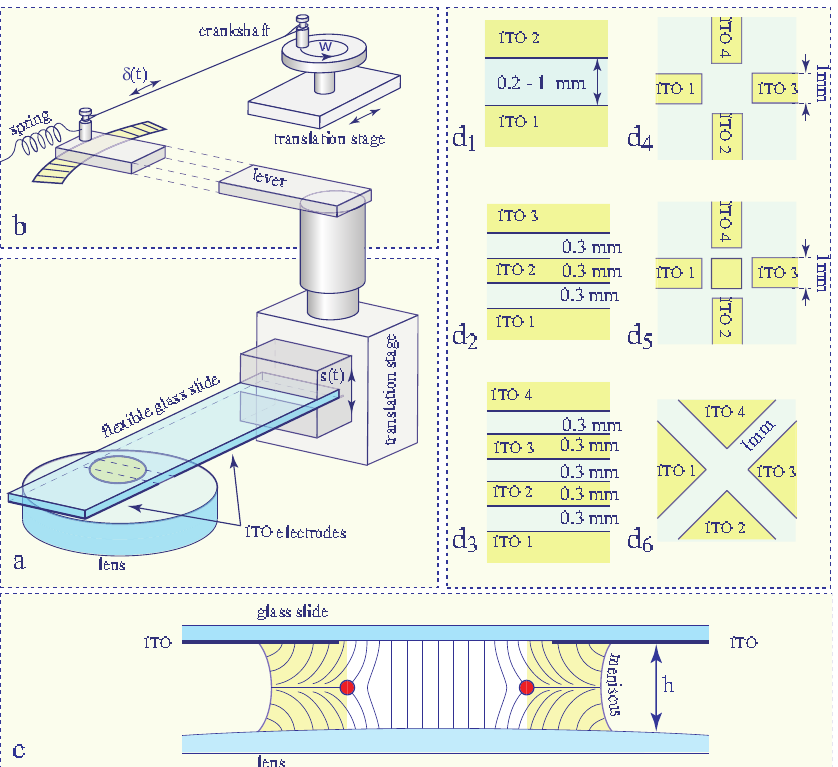
Figure 4. Setup. a) General view. b) Lever-crankshaft system for modulation and control of the gap thickness. c) Cross section through the sample. d) Systems of ITO electrodes.